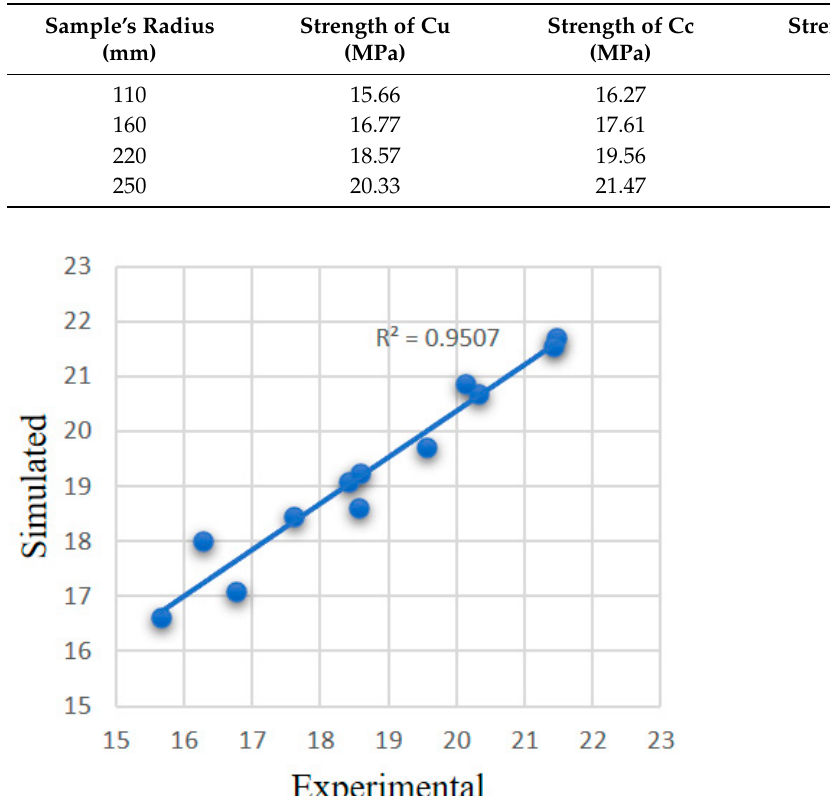
Figure 16. Relative error distribution for each diameter using the FE approach for all scenarios.